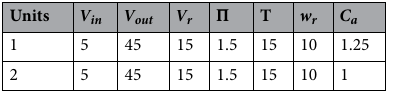
Table 2. Wind power units input data.